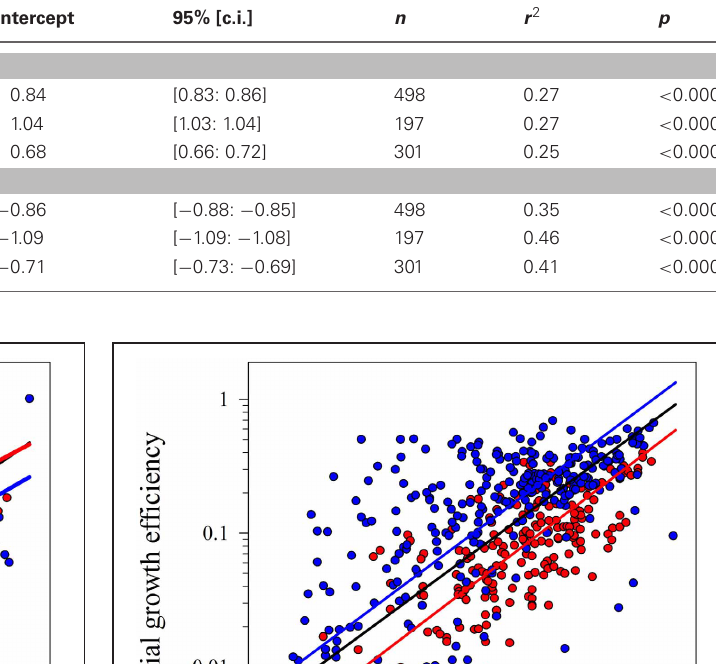
Table 2 | Slope, intercept and confidence interval (c.i.) of Type II Linear Regressions between log transformed BP vs. BR, and BP vs. BGE for tropical, temperate and whole dataset.